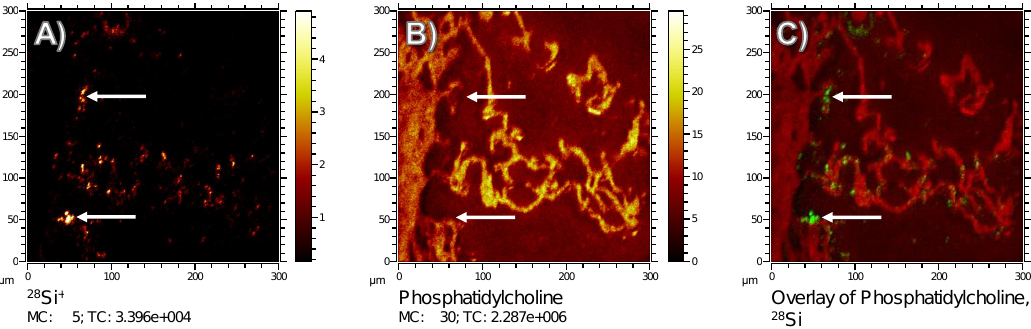
Figure 6. Comparison of the Si and phosphocholine distribution in a cryo-section of the rat lung 30 min post administration of Fe-Si-NP. All images contain information of the uppermost 20 scans only. ( A ) 28 Si + ; ( B ) C 5 H 15 NPO 4+ , which is the 184.07 fragment of the phosphocholine (PC) head group showing the distribution phosphatidylcholine; and ( C ) the overlay of ( A , B ). Arrows in all images point to the position of larger agglomerates of Fe-Si-NP; note that in ( B ) PC is not detected at the indicated sites.